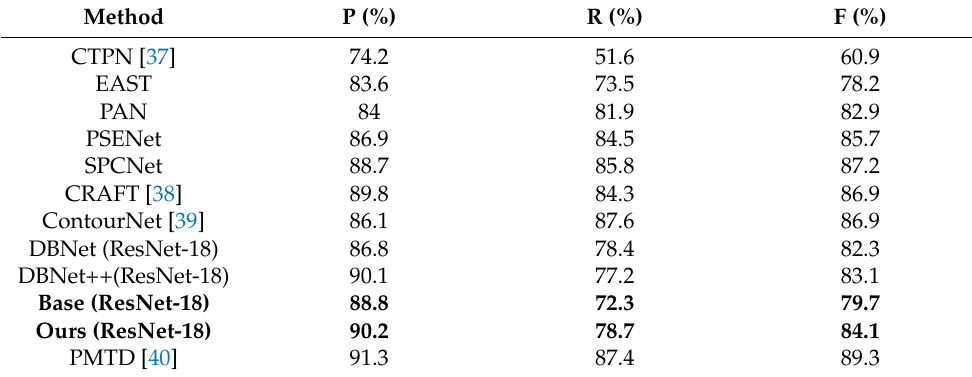
Table 2. Detection results on the ICDAR2015